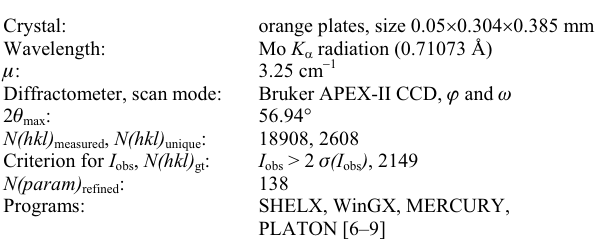
Table 1. Data collection and